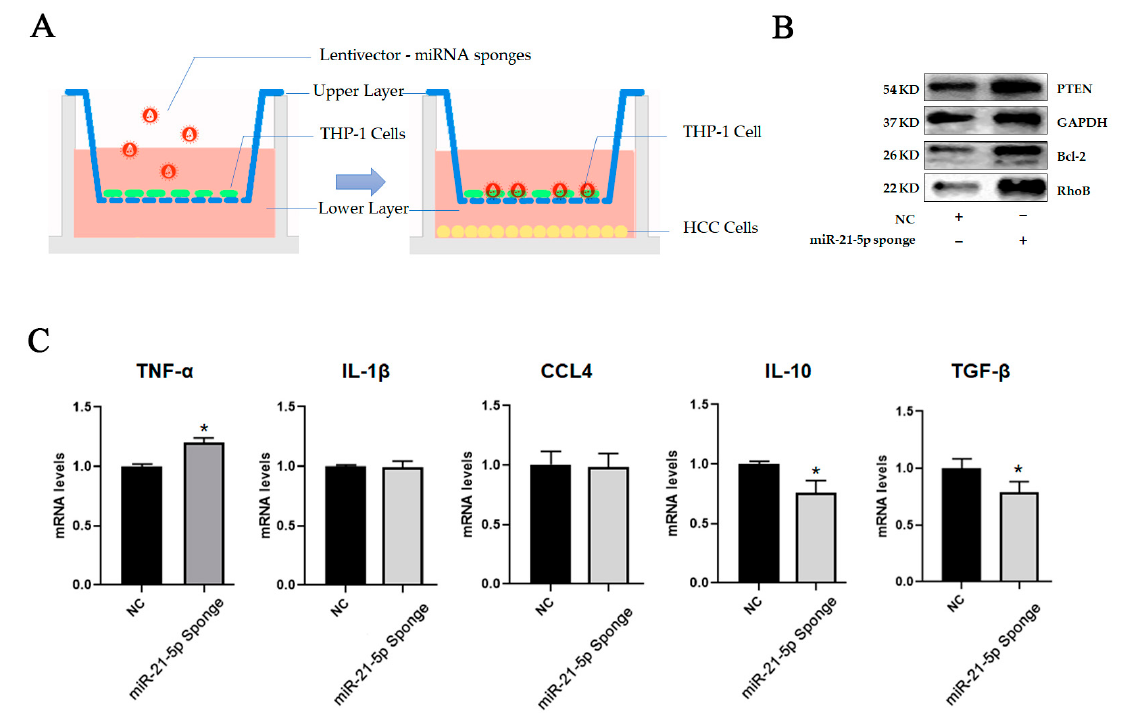
Figure 7. HCC-derived exosomal miR-21-5p regulated macrophage polarization by target RhoB. ( A ) THP-1 cells were seeded on upper layer after transfection with miRNA sponges. HCC cells were seeded on lower layer. Two kinds of cells were cultured for 48 h. ( B ) The levels of targets of miR-21-5p in HCC cells were detected using Western-blot analysis. ( C ) Cytokines in THP-1 were detected by qPCR, * p < 0.05.